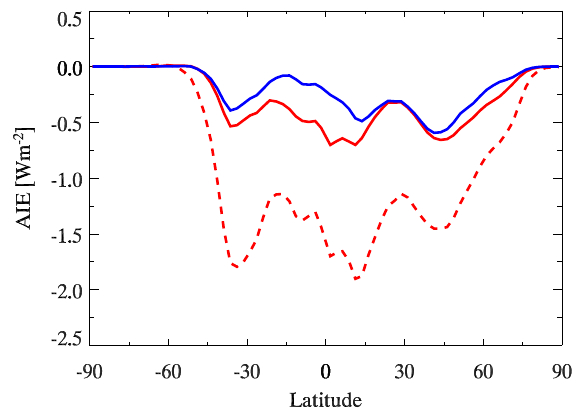
Fig. 7. Zonal annual mean cloud albedo aerosol indirect effect (AIE) due to carbonaceous combustion aerosol. The AIE is shown for all carbonaceous combustion aerosol (red line) and for pollu- tion (fossil fuel and biofuel) carbonaceous combustion aerosol (blue line). The red dashed line shows the AIE for all carbonaceous com- bustion aerosol when we assume that they are emitted at smaller particle sizes (small CCA). See Table 3 for description of model